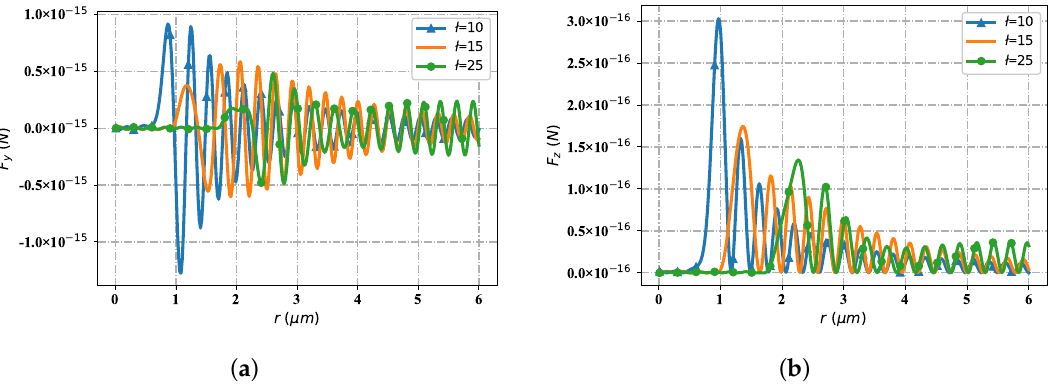
Figure 16. The influence of beam order l for optical force component F y and F z . ( a ) F y with different ł; ( b ) F z with different